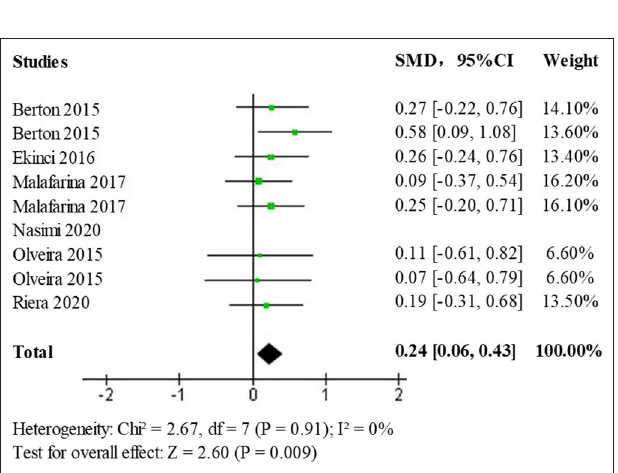
between studies. Results obtained using a fixed-effects model (SMD = 0.48; 95% CI: 0.27, 0.69; p < 0.00001) showed statistically significant differences ( p < 0.05) among the treatment population, the forest plot is shown in Figure 7 .